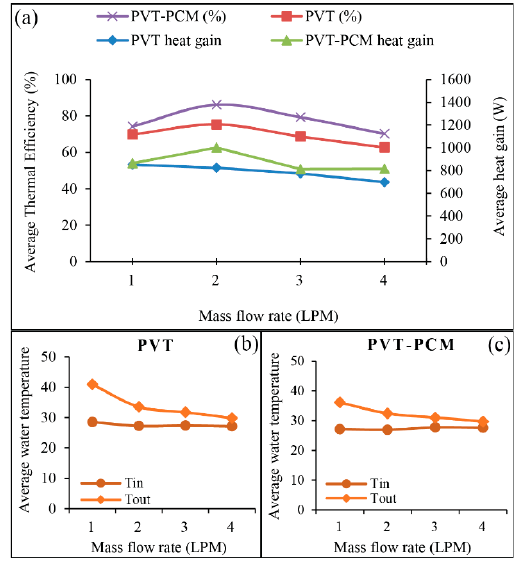
Figure 6. ( a ) Average thermal efficiency, heat gain, and ( b , c ) water temperature of PVT and PVT-PCM collectors as a function of water flow rate.